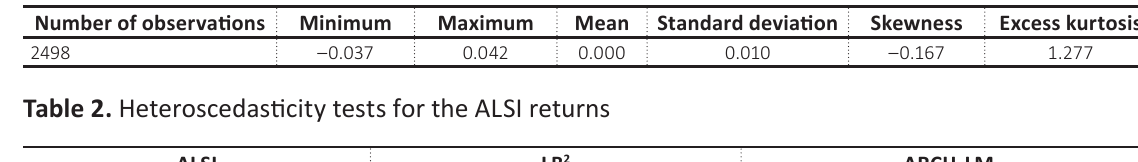
Table 1. Descriptive statistics of the ALSI returns